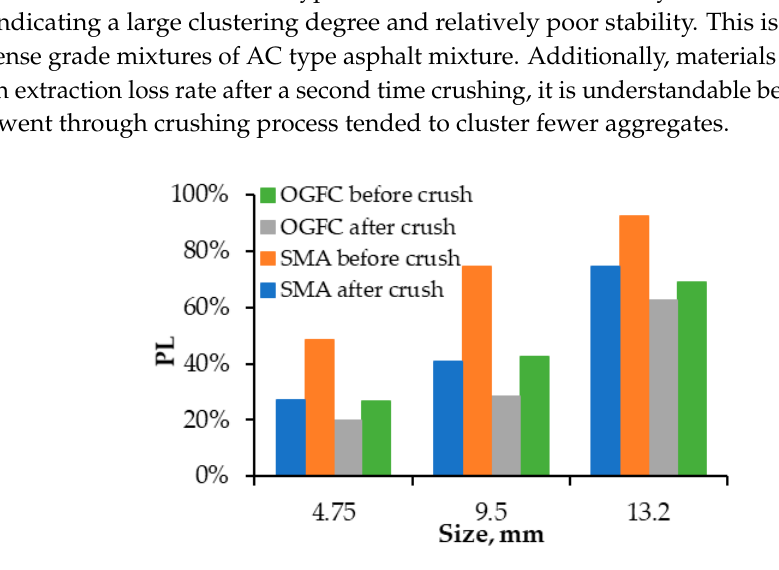
Figure 11. Percentage Loss ( PL ) Rate of RAP material.